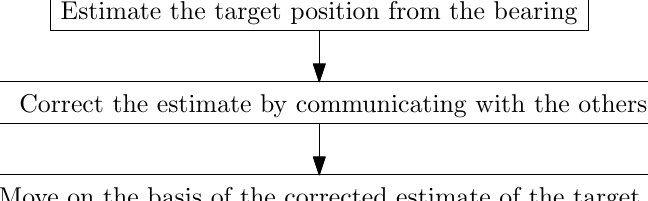
Figure 3. Workflow of the single